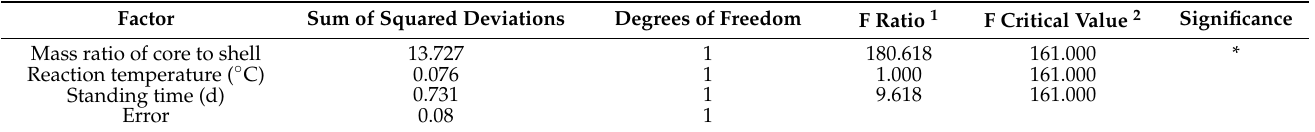
Table 5. Variance results of microcapsule output by the orthogonal test.